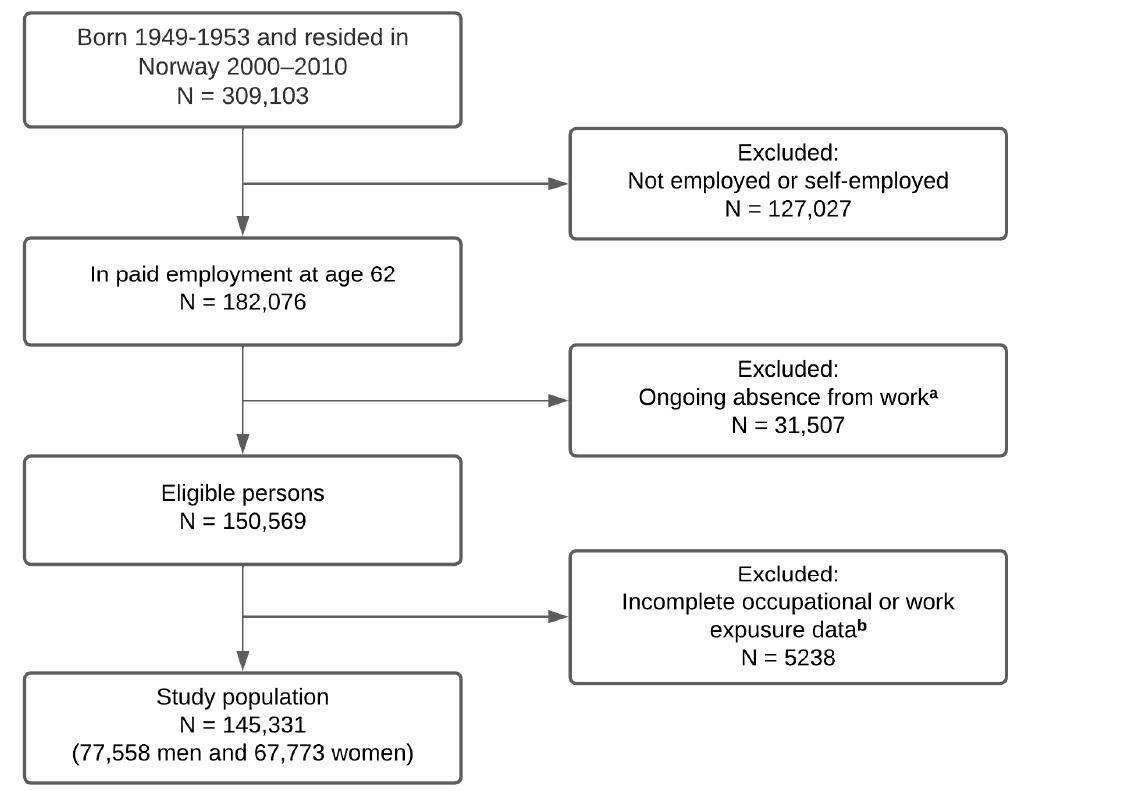
Figure 1. Flow diagram of the study selection process .